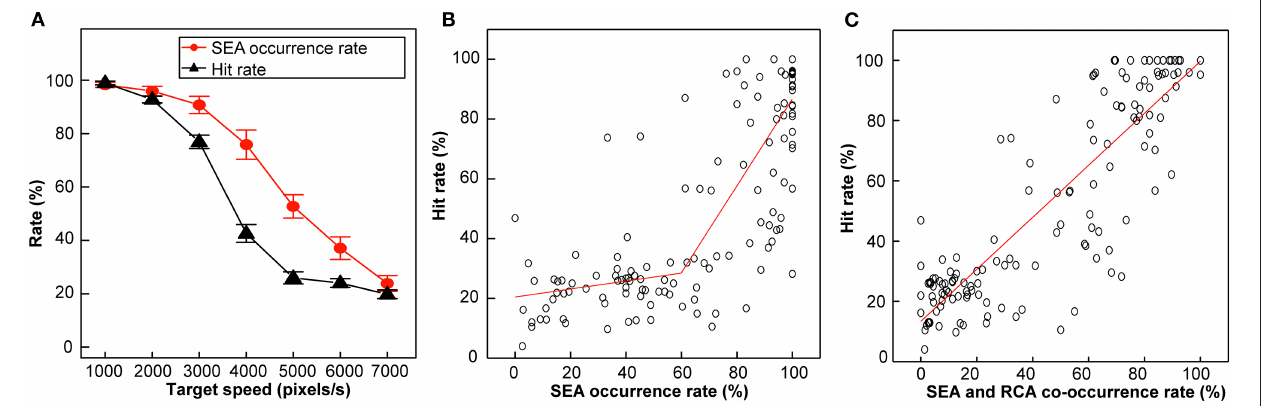
(SEA), respectively. SEA occurrence rate was calculated as the incidence percentage of saccades determined from the vertical component of gaze movement relative to the total number of